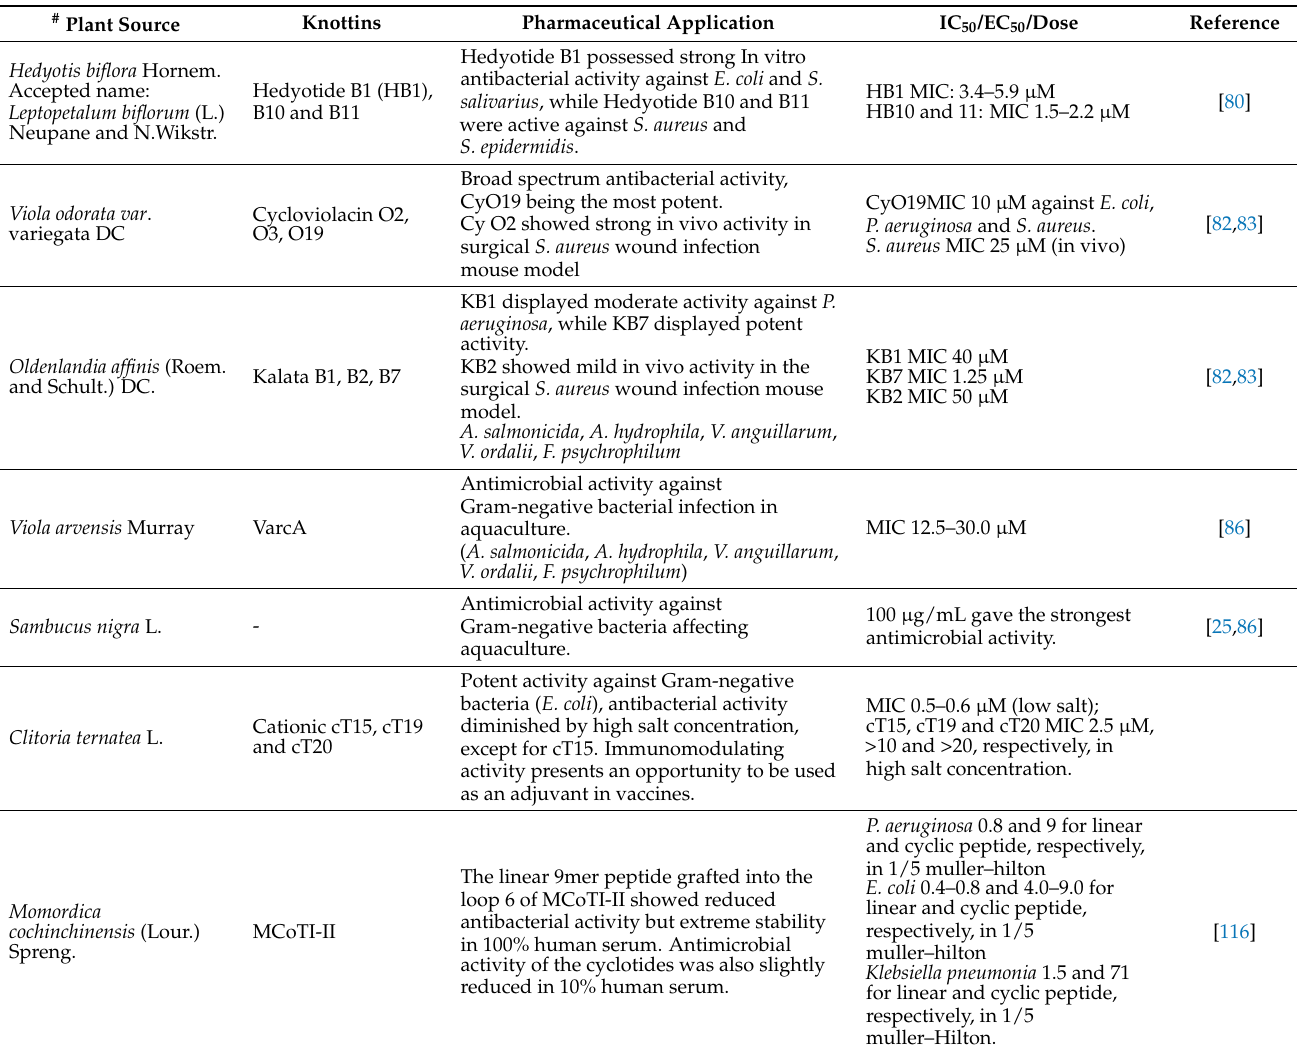
Phytomedicines rich in knottins, plant source, dose and potential pharmaceuti- cal/biotechnological